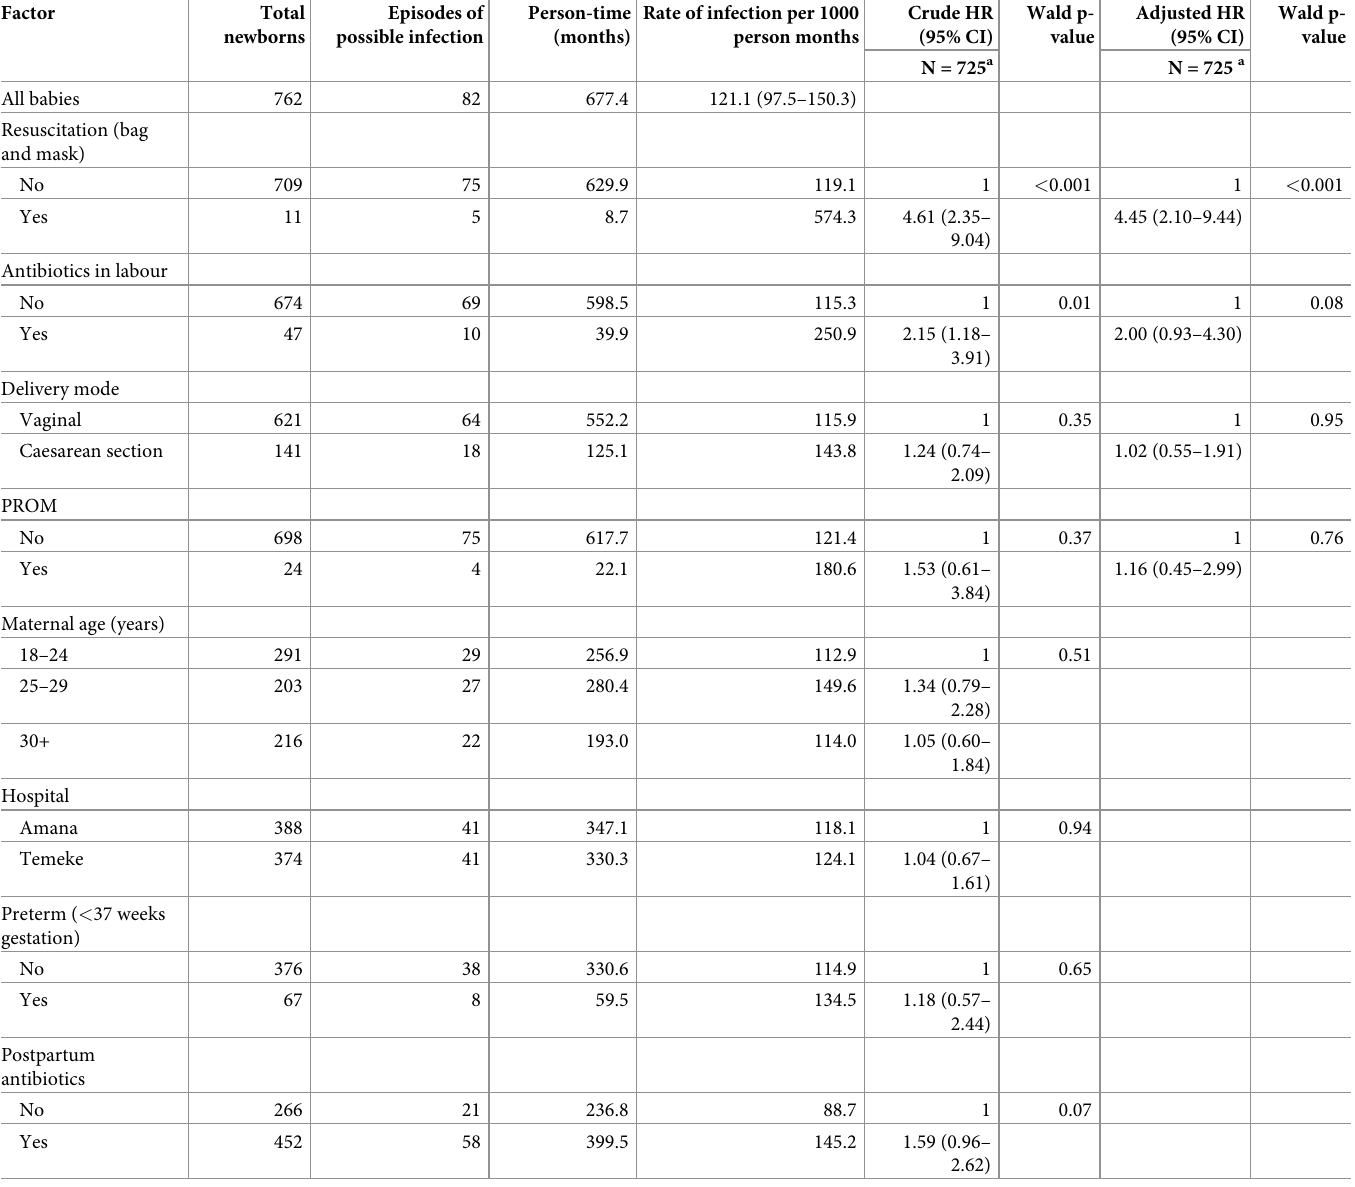
Table 6. Association between potential risk factors and rate of possible newborn